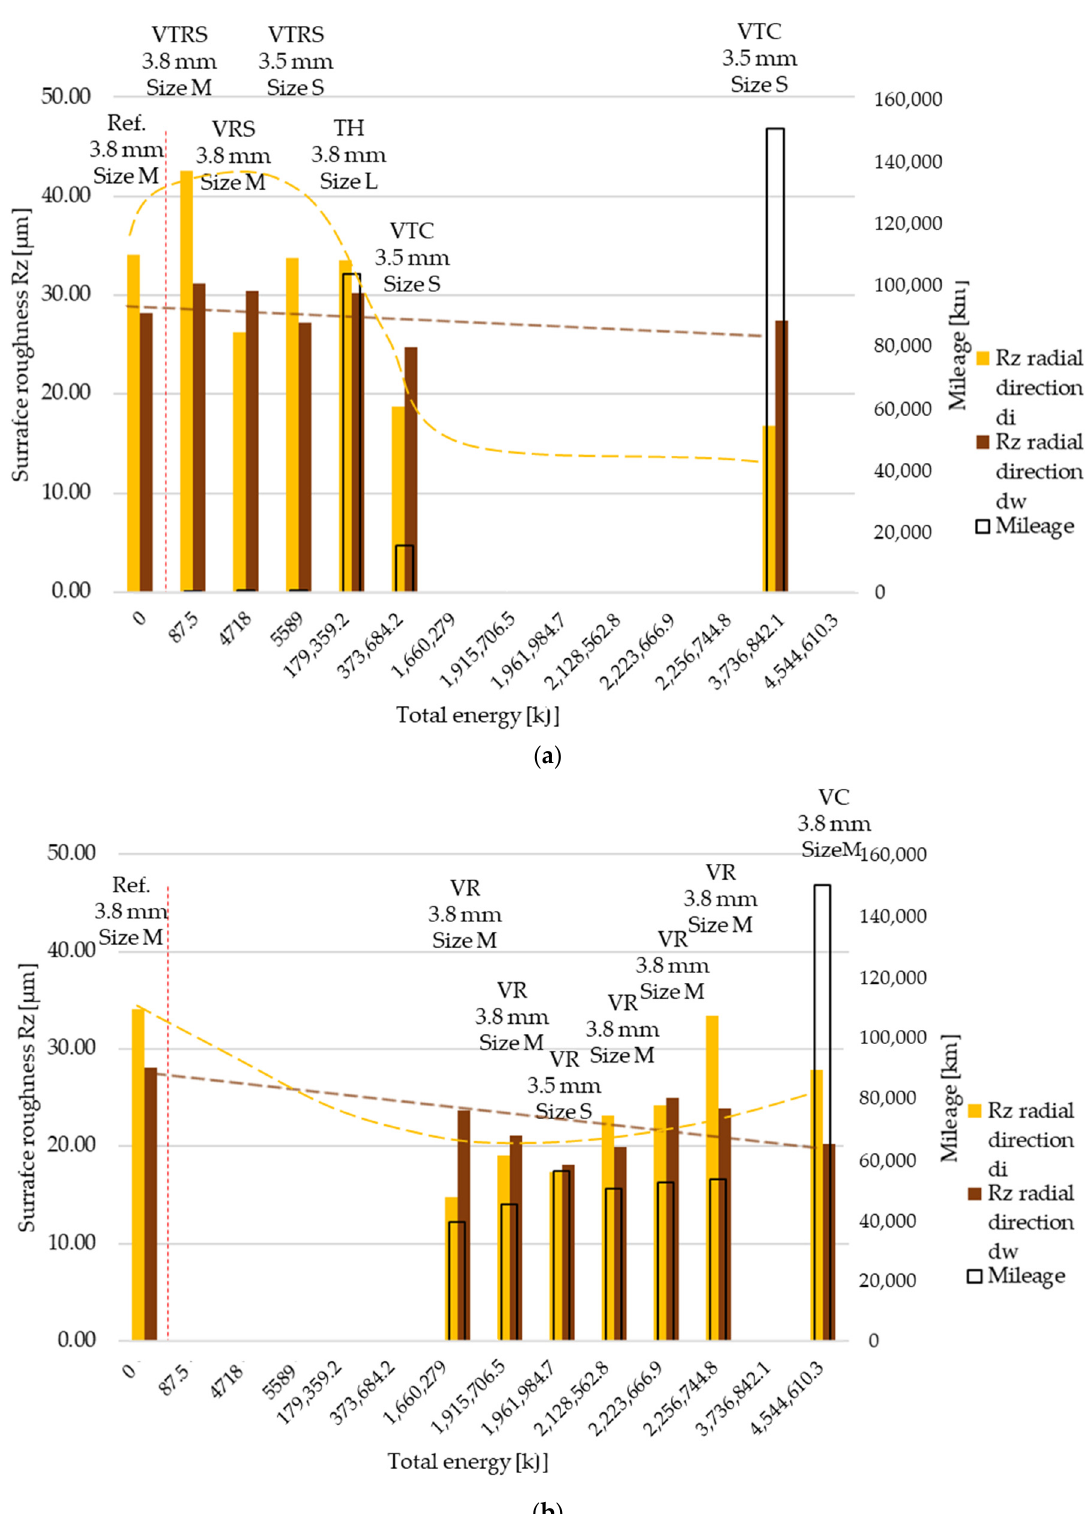
Figure 7. ( a ) Rz surface roughness values, radial direction–trend 1: clutch killer tests. ( b ) Rz surface roughness values, radial direction—trend 2: moderate tests.